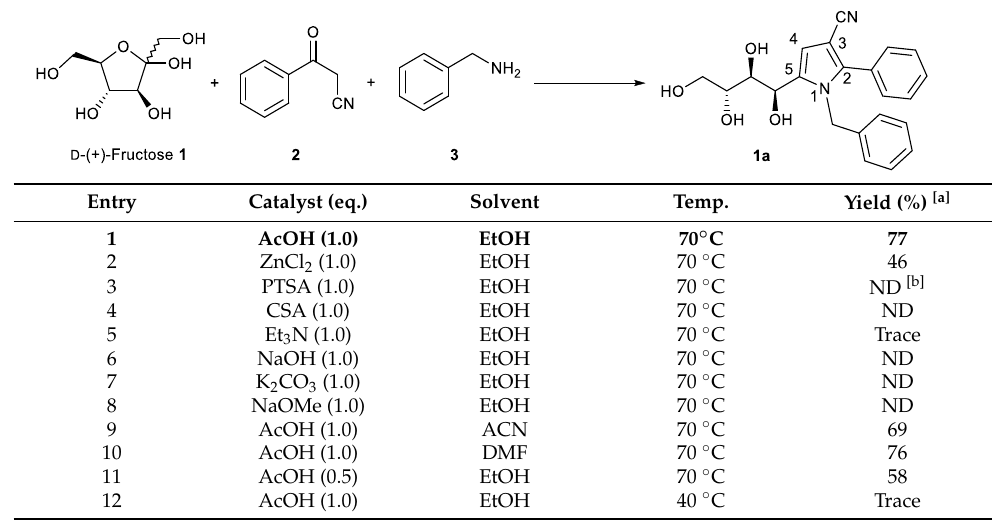
Table 1. Optimization of the reaction conditions for the three-component synthesis of 3-cyanopyrrole 1a .